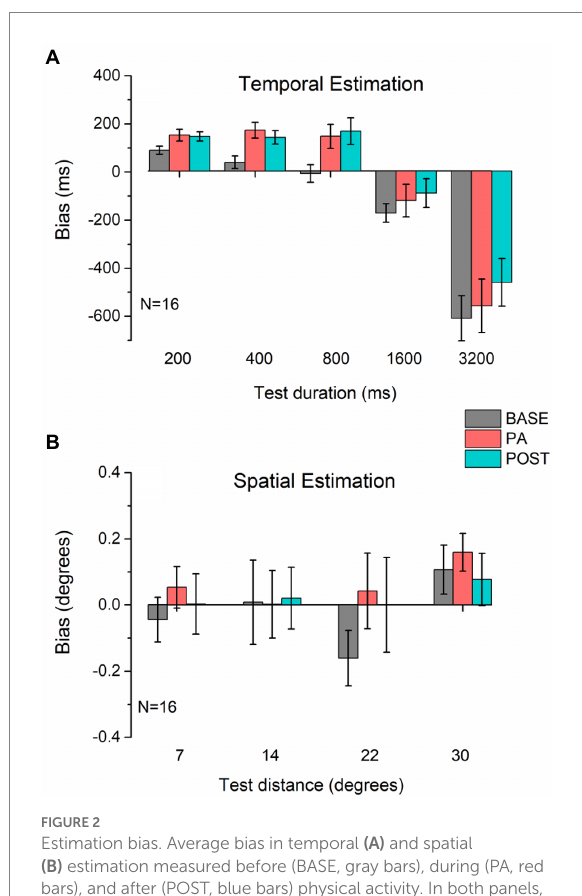
FIGURE 2 Estimation bias. Average bias in temporal (A) and spatial (B) estimation measured before (BASE, gray bars), during (PA, red bars), and after (POST, blue bars) physical activity. In both panels, values above the dotted line (0) indicate an overestimation of time (A) or distance (B) , while values below zero indicate underestimation. Error bars represent 1 ±